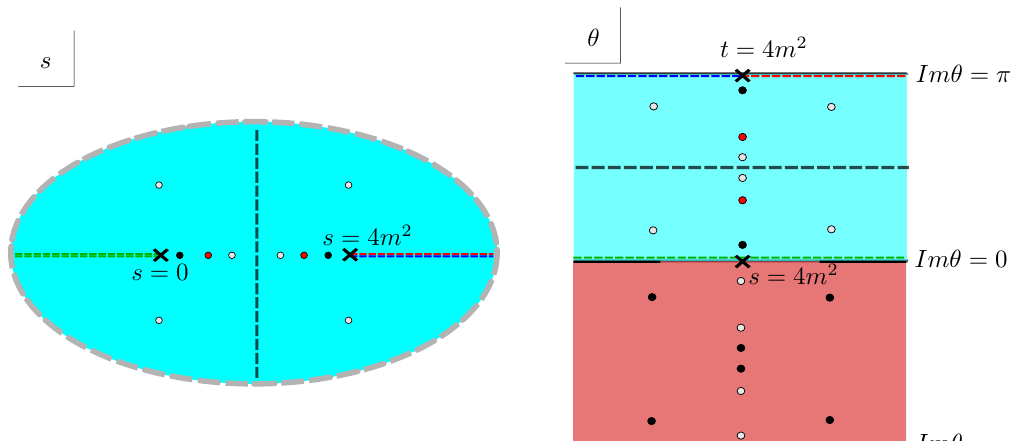
Figure 2. A typical set of poles (black and red dots) and zeros (grey dots) of a 2 → 2 S-matrix element on the s -plane (left) and on the θ -plane (right). The poles due to the self-coupling of the particle are represented by red dots. Blue and green dashed lines correspond to physical scattering in s and t channels respectively. On the physical strip of the θ -plane (corresponding to the first sheet of the s -plane), zeros are allowed everywhere but they must appear in complex conjugate and crossing symmetric quadruplets (or pairs if they are on the imaginary line or on the crossing symmetric line), whereas poles are allowed only on for purely imaginary θ